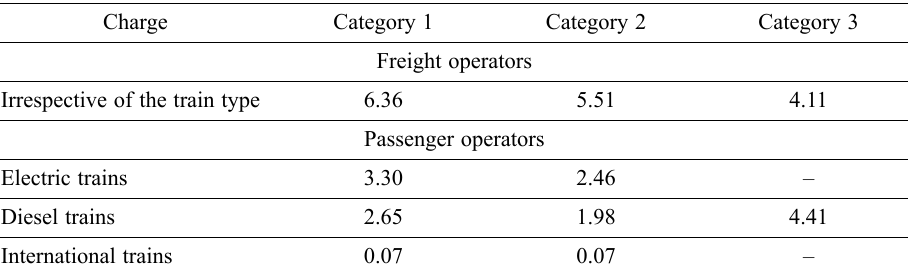
Table 1. Charges for using infrastructure (for 1 km, in EUR)